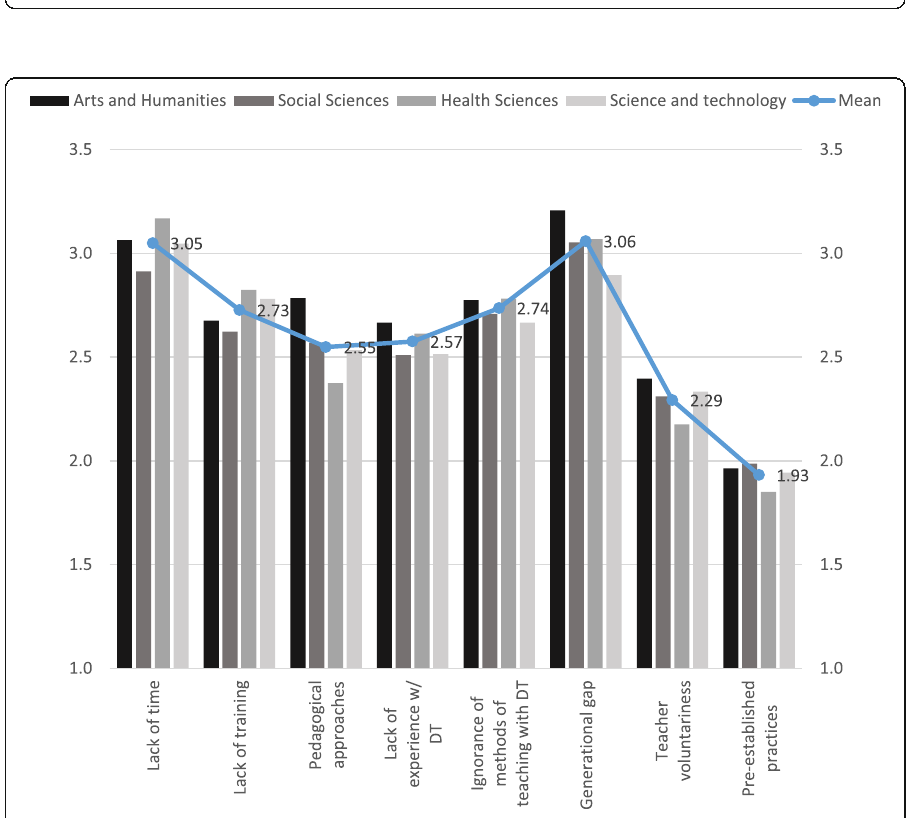
Fig. 3 Mean ranking for professional barriers to DT integration according to academic